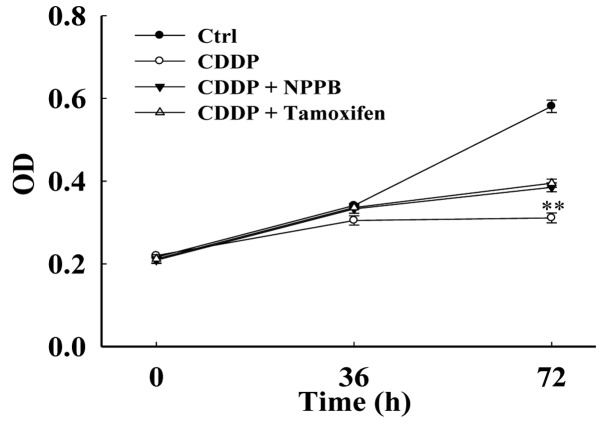
Chloride channel blockers increase proliferation of cisplatin-treated MG-63 human osteosarcoma cells. The cells were cultured in 96-well culture plates (at a density of 2,500 cells/well) in control medium overnight (~16–18 h), and were then incubated in control medium (Ctrl) or medium containing cisplatin (CDDP; 2 μg/ml) alone, or in combination with 5-nitro-2-(3-phenylpropylamino)-benzoate (NPPB; 100 μM) or tamoxifen (20 μM) for 36 or 72 h. The relative cell numbers were detected by an MTT assay and the optical density (OD) of the cells was measured. The figure shows the comparison of cell growth to standardized OD values at different time points in MG-63 cells. The data represent the mean ± standard error of three experiments. **P<0.01, vs. the control.